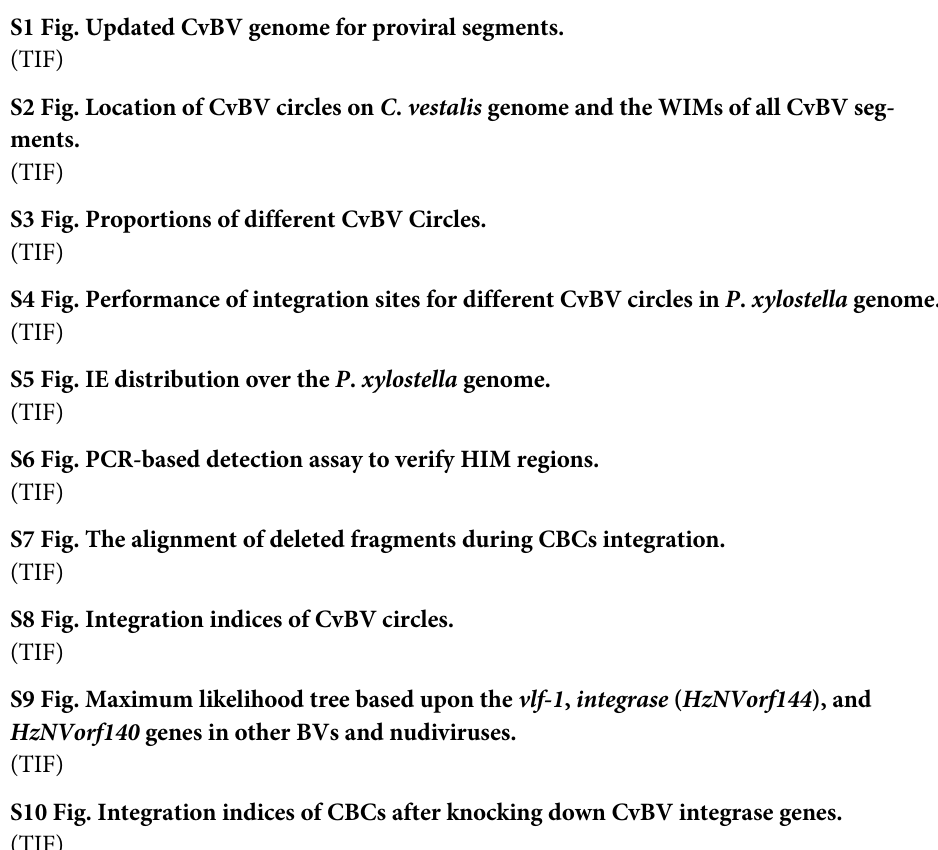
S1 Fig. Updated CvBV genome for proviral segments. (TIF) S2 Fig. Location of CvBV circles on C . vestalis genome and the WIMs of all CvBV seg- ments. (TIF) S3 Fig. Proportions of different CvBV Circles. (TIF) S4 Fig. Performance of integration sites for different CvBV circles in P . xylostella genome. (TIF) S5 Fig. IE distribution over the P . xylostella genome. (TIF) S6 Fig. PCR-based detection assay to verify HIM regions. (TIF) S7 Fig. The alignment of deleted fragments during CBCs integration. (TIF) S8 Fig. Integration indices of CvBV circles. (TIF) S9 Fig. Maximum likelihood tree based upon the vlf-1 , integrase ( HzNVorf144 ), and HzNVorf140 genes in other BVs and nudiviruses. (TIF) S10 Fig. Integration indices of CBCs after knocking down CvBV integrase genes. (TIF) S11 Fig. Transcriptome analysis for identification of two host integrase enzymes. (TIF) S12 Fig. Phylogenetic analysis of integrase 1 and integrase 2 genes. (TIF) S1 Table. The basic features of the CvBV resequencing genome. (XLSX) S2 Table. The information of CvBV ORFs. S3 Table. The location of CvBV resequencing segments on C . vestalis genome. S4 Table. The basic features of sequence Rawdata of hemocytes of P . xylostella at 24h p.p. (XLSX) S5 Table. Reads numbers of CvBV circles. S6 Table. Summary of the read counts per